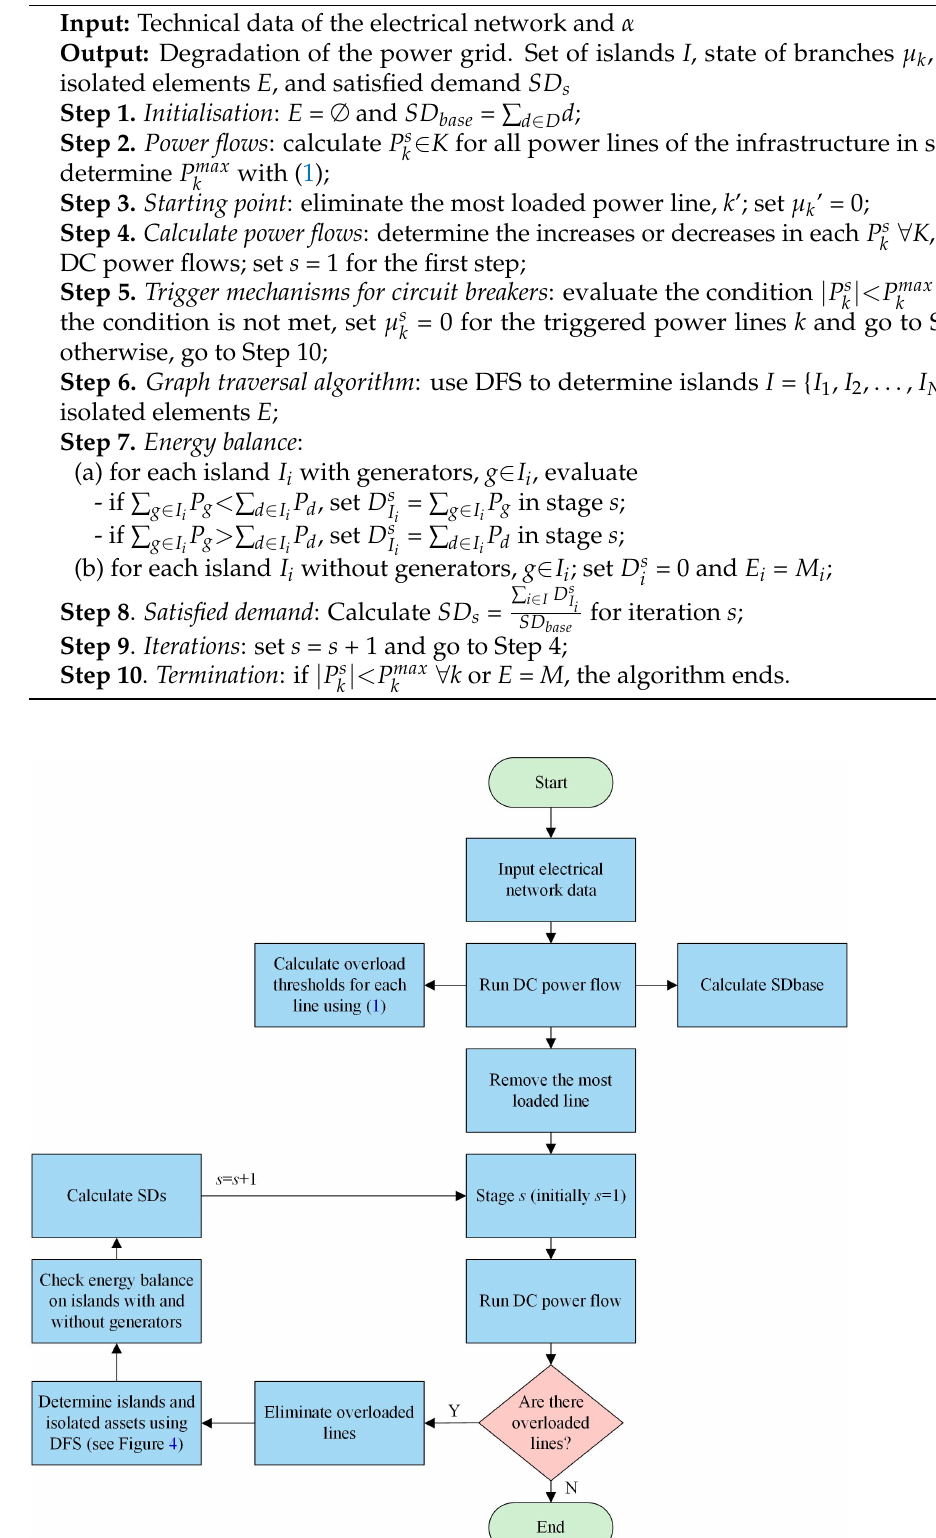
Algorithm 1: Disruption stage. Cascading failures.